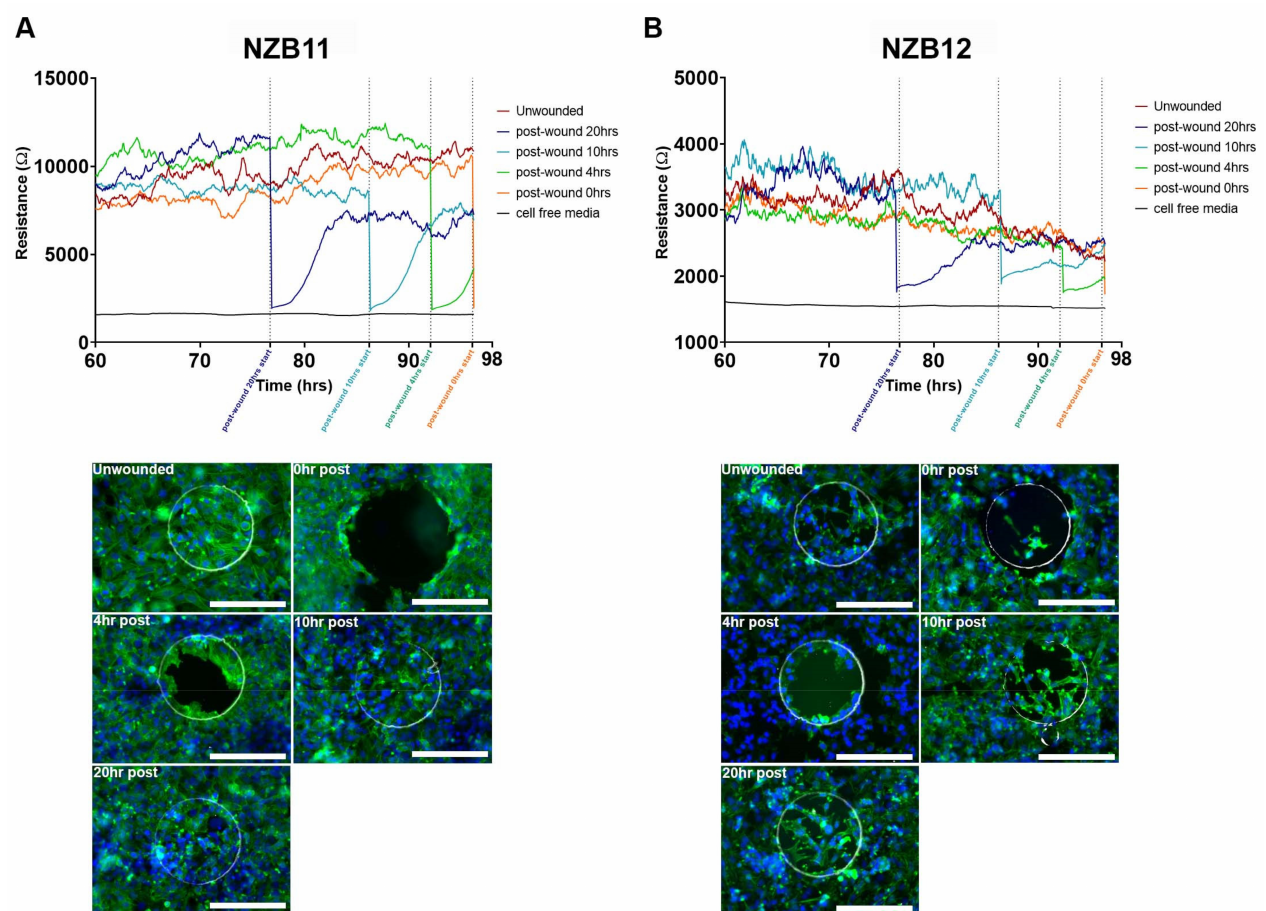
Figure 6. Wound healing profiles of serum-derived GBM cells. ( A ) NZB11 and NZB12 serum-derived cells grown on 8W1E ECIS arrays for 76 h (time point at which stable resistance measurements are acquired). Cells were seeded at 80,000 cells per 0.33 cm 2 . Wounding was induced at 76, 86, 92, and 96 h post-seeding. Wound healing measurements were carried out for 20, 10, 4, and 0 h, corresponding to each wounding time point. Data shows resistance measurements acquired between 60–98 h. Data are representative of three independent replicates. ( B ) Representative fluorescent images show electrode regions 0, 4, 10, and 20 h post-wounding. Unwounded control shown for reference. Cells were stained with Actin Green™ 488 (green) and Hoechst 33342 (blue). Phase electrode ring shows the periphery of each electrode. Images acquired at 20 × magnification. Scale bar = 200 µ m. Data is representative of three independent